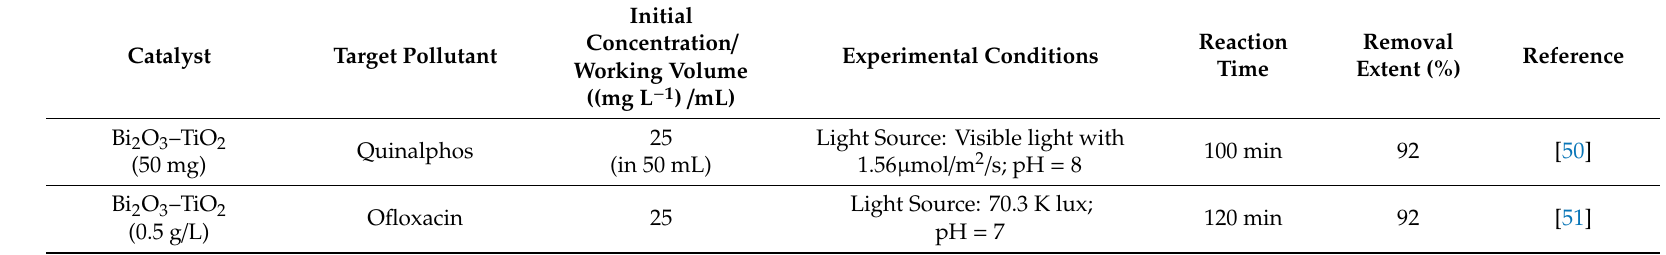
Table 5. Photocatalytic degradation of CEC’s over TiO 2 / Bi 2 O 3